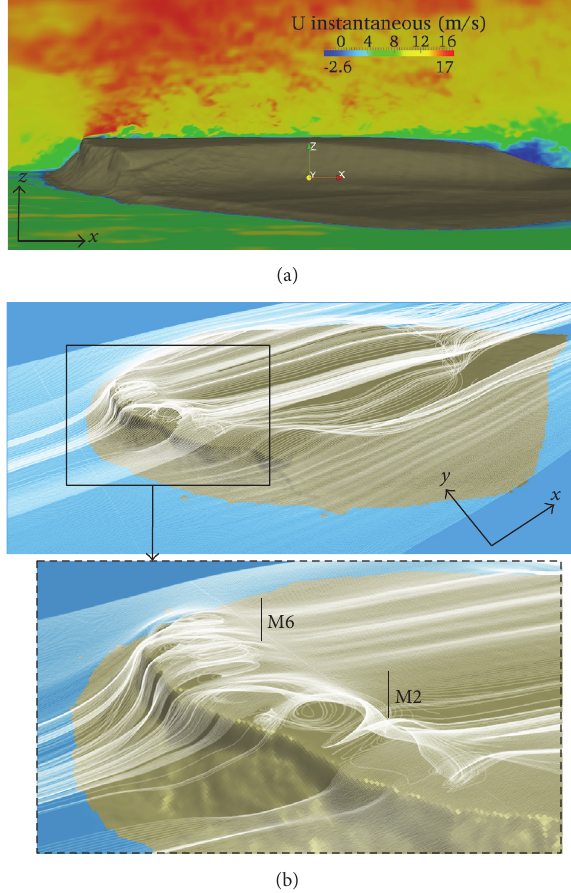
Figure 5: LES-predicted instantaneous stream-wise velocity fields on the vertical plane (a), and the 10 min time-averaged streamlines along the hill (b). The results are from the 270 ∘ wind